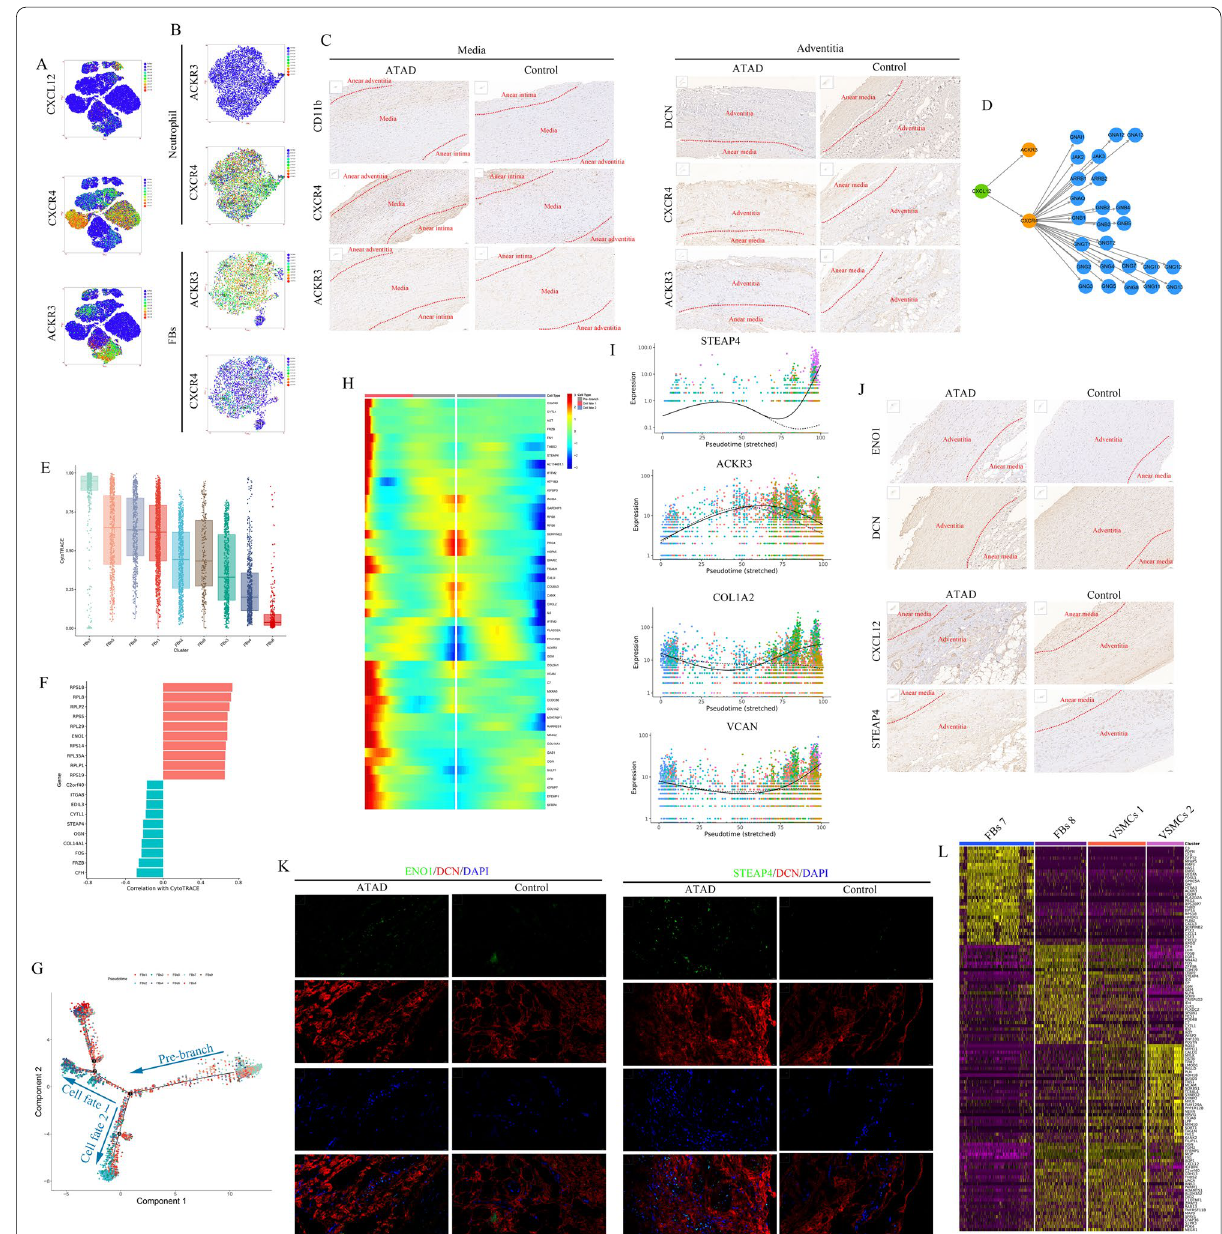
Fig. 6 The interaction among VSMCs, FBs and neutrophils in control and ATAD group as well as cell differentiation trajectory of FBs. A t‑SNE plots exhibited the expressions of CXCL12, CXCR4 and ACKR3 in all cell types. B t‑SNE plots exhibited the expressions of CXCR4 and ACKR3 in neutrophils and FBs. C IHC revealed higher expression of CXCR4 in CD11b + cells for media of ATAD group and ACKR3 in DCN + cells for adventitia of ATAD group. D the predicted downregulation targets upon the combination of CXCL12 with CXCR4/ACKR3. E CytoTRACE predicted the cell differentiation potential of FBs. F genes correlated with more differentiated and less differentiated cells predicted by CytoTRACE. G pseudo‑time analysis showed the cell differentiation trajectory of FBs upon selecting FBs 7 as the initiate. H the heatmap of gene expression alteration relating to ECM organization and cell proliferation. I the alteration curves of representative genes. The full line represented cell fate 1, the dashed line represented cell fate 2. J IHC showed higher expressions of ENO1 in DCN + FBs from ATAD adventitia and higher proportion of CXCL12 + /STEAP4 + cells in adventitia of ATAD group. K IF verified the higher expressions of ENO1 and STEAP4 in DCN + FBs from ATAD adventitia. L heatmap showed similar expressions of marker genes between FBs 8 (synthetic VSMCs‑like FBs) and VSMCs 1 (synthetic VSMCs) and distinct markers of FBs 7 and VSMCs